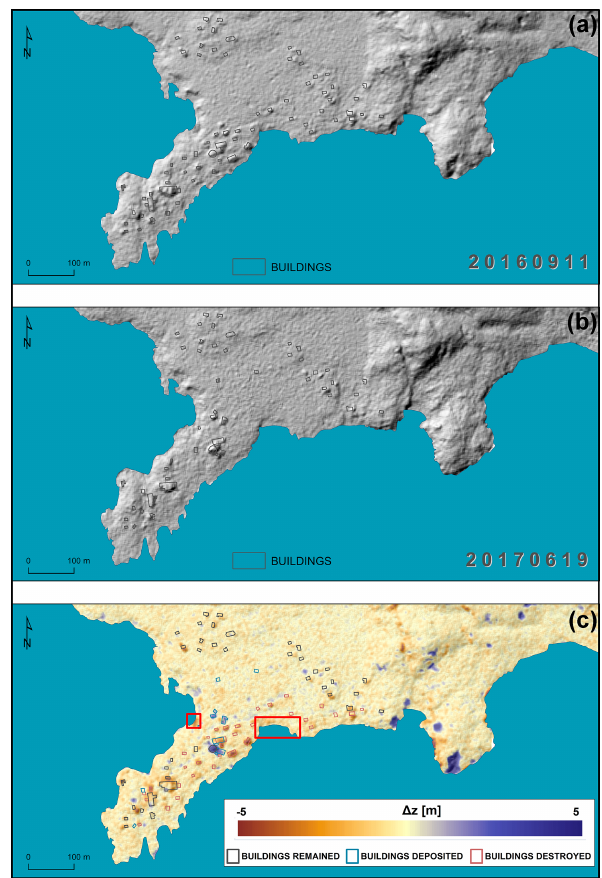
Figure 6. Post-tsunami terrain change in the Nuugaatsiaq area. (a) DTM of study site on 11 September 2016 – pre-tsunami condi- tions. (b) DTM of study site on 19 September 2017 – post-tsunami conditions. (c) Terrain change calculated from data of two digital terrain models (DTM). The colour scale illustrates values of terrain change ( (cid:49)z ), where warm colours stand for an elevation decrease due to erosion, and cold colours represent an elevation increase led by the effects of deposition. Please notice that major changes in the terrain are associated with construction, destruction, or relocation of buildings. The resolution of the model (2m) precluded detection of small-scale landscape modifications observed during the fieldwork. Two sites where both field observations and remote sensing analy- ses detected significant change (erosion) were the beach (site 4 in Fig. 1) and cliff edge in the harbour (site 7 in Fig. 1) on the opposite sides of the saddle (marked by red rectangles).